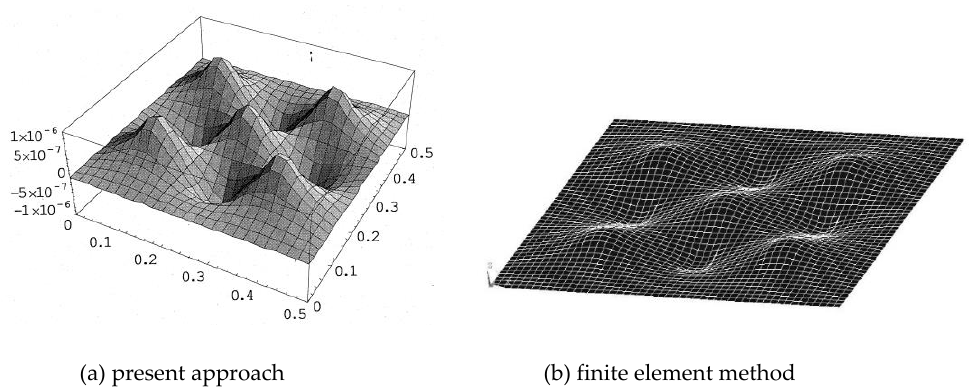
Figure 15. Distributed PZT actuators arranged in a 3 × 3 array surface bonded on a composite laminate.